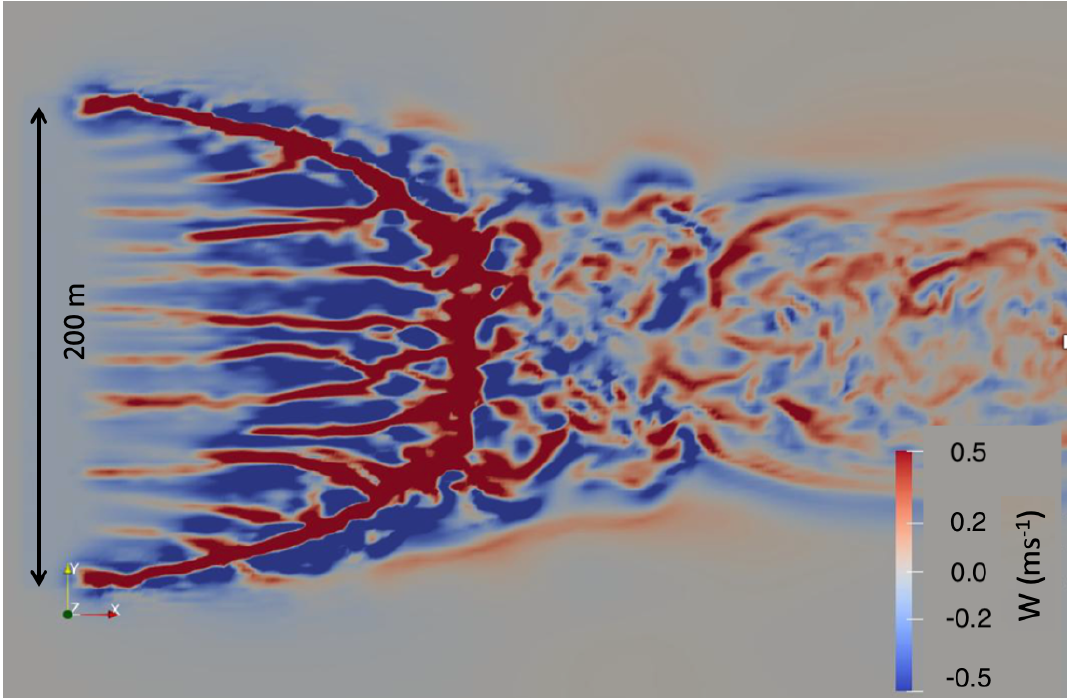
Figure 1. Visualization of counter-rotational vortices and tower—trough structures. This is a snapshot of FIRETEC simulation, showing instantaneous vertical (w) velocity. The red structures indicate towers and the blue structures are troughs [3]. The prevailing wind direction is from left to right. A scale is shown for